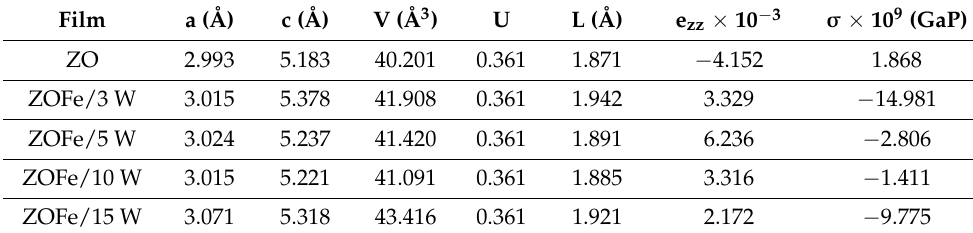
Table 4. Values of lattice constants, cell volume, internal parameter, bond length, strain and the compressive stress for the wurtzite hexagonal ZO and ZOFe films deposited at different DC powers.